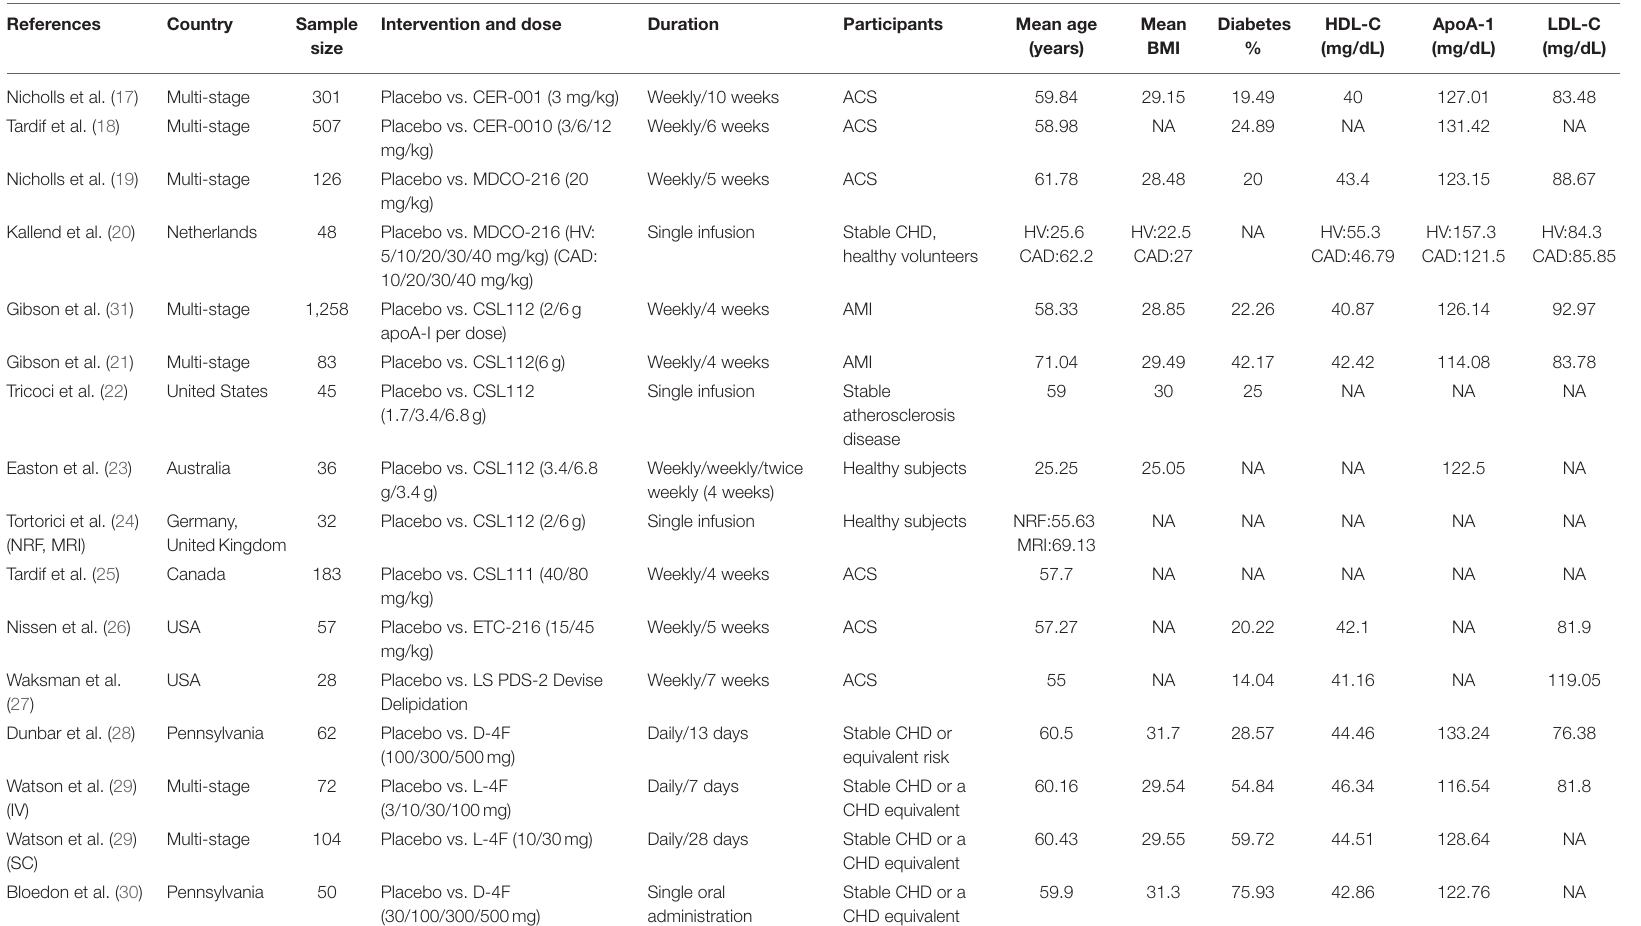
TABLE 1 | Characteristics of the studies included in the human